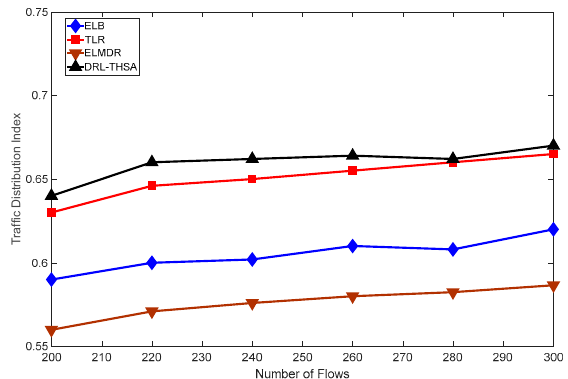
Figure 11. The tra ffi c distribution index with di ff erent number of Figure 11. The traffic distribution index with different number of flows. Figure 11. The traffic distribution index with different number of flows.